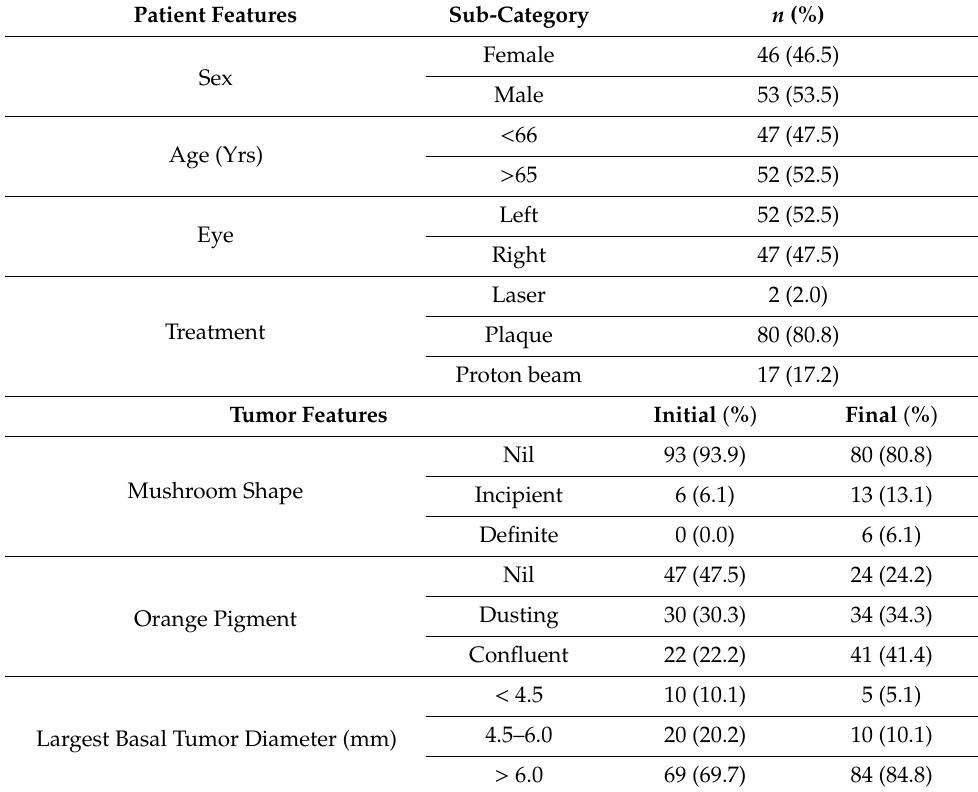
Table 3. Patient and tumor features at initial and final